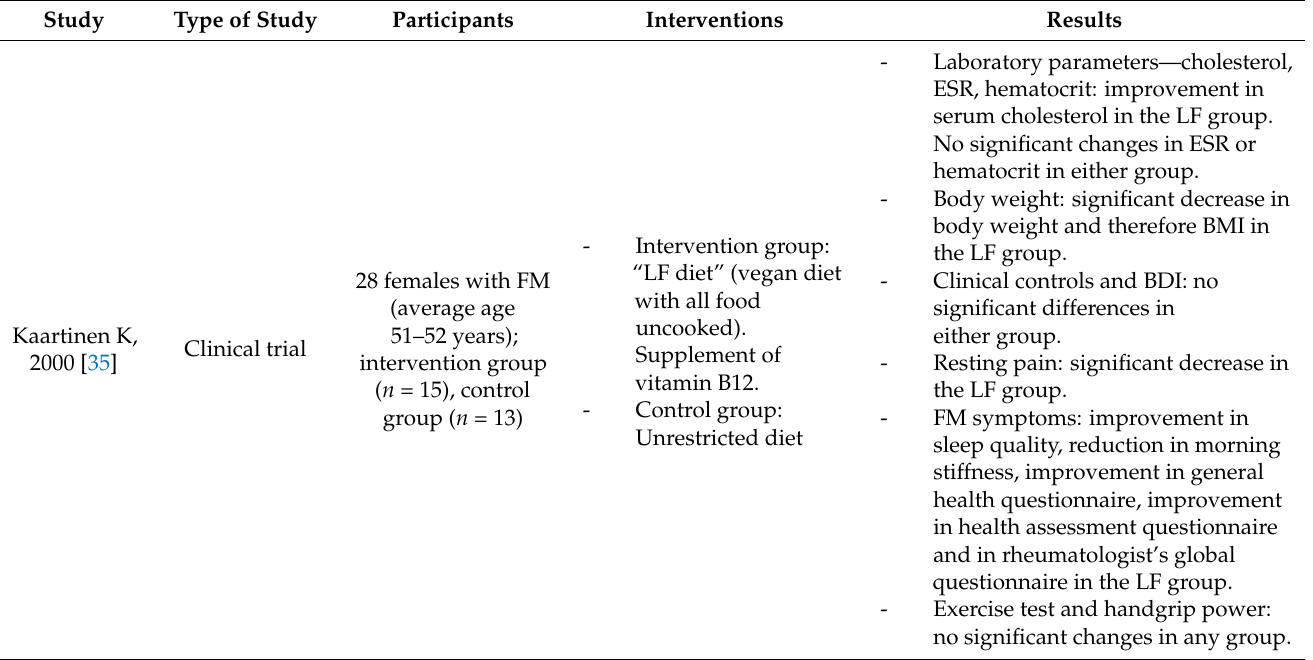
Figure 1. PRISMA diagram: Flowchart of study section process. Table 1. Vegetarian or vegan interventions in fibromyalgia